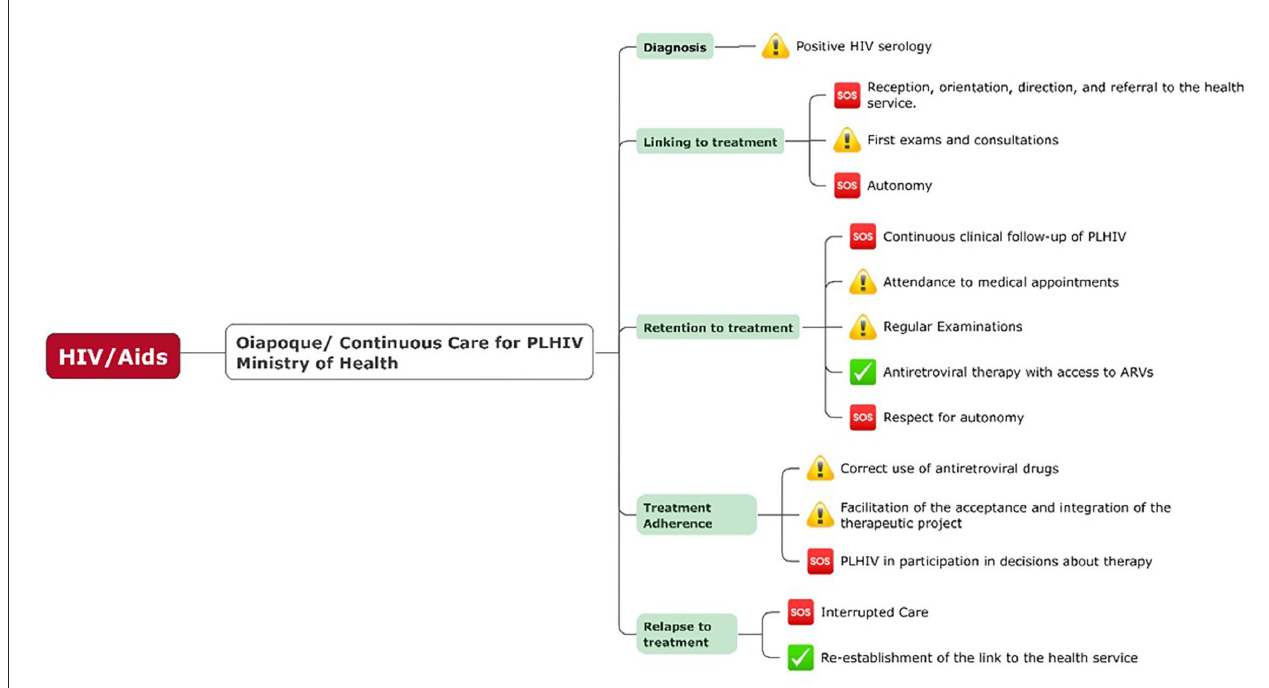
FIGURE4 The necessary pathway of continuous care for people living with HIV (PLHIV) recommended by the Ministry of Health, from diagnosis to continuous treatment, marked with symbols of attention, S.O.S, and “check” in green, referring to the points that need attention and care, as well as the points that the service has a good resolution. Source: Own preparation based on the descriptions of the Manual of Combined Prevention of HIV–Ministério da saúde (1) based on the construction of the results and analysis carried out in